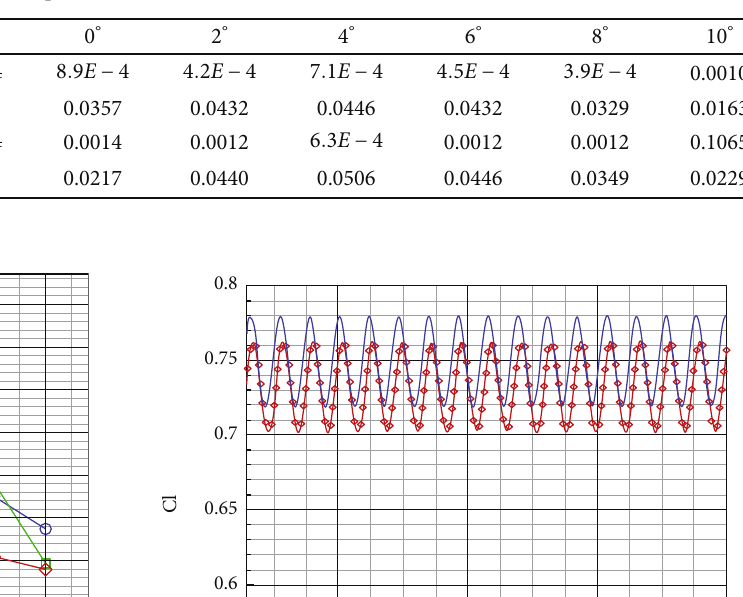
Table 7: Comparisons of Δ Cl at Re = 1 : 4 × 10 6 .